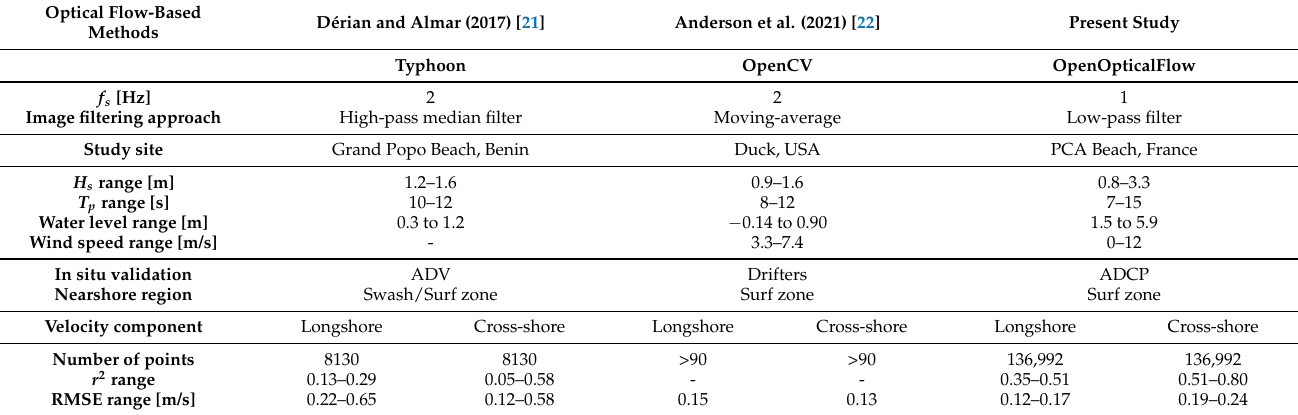
Table 4. Comparison of optical flow-based techniques previously reported in the literature for estimating nearshore surface currents under different field conditions at different